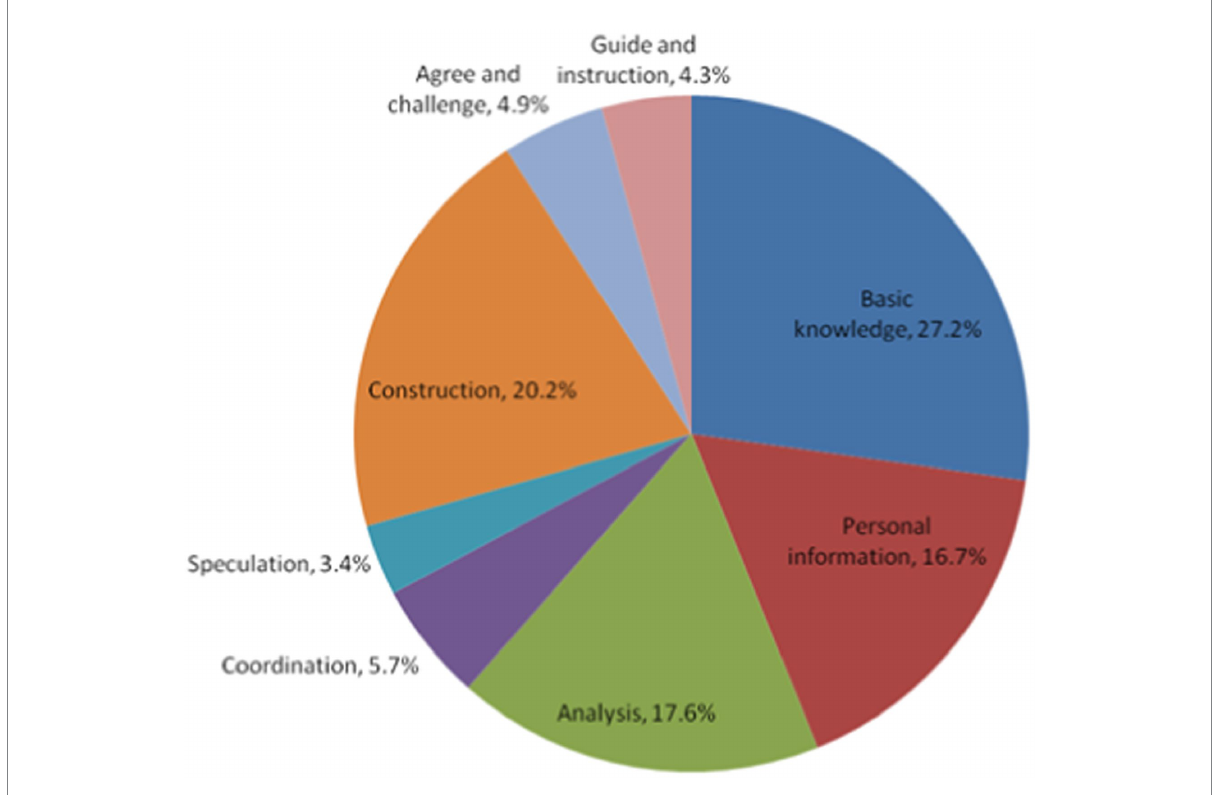
FIGURE 1 Distribution of dialog types in expert teachers’ classrooms (first-level